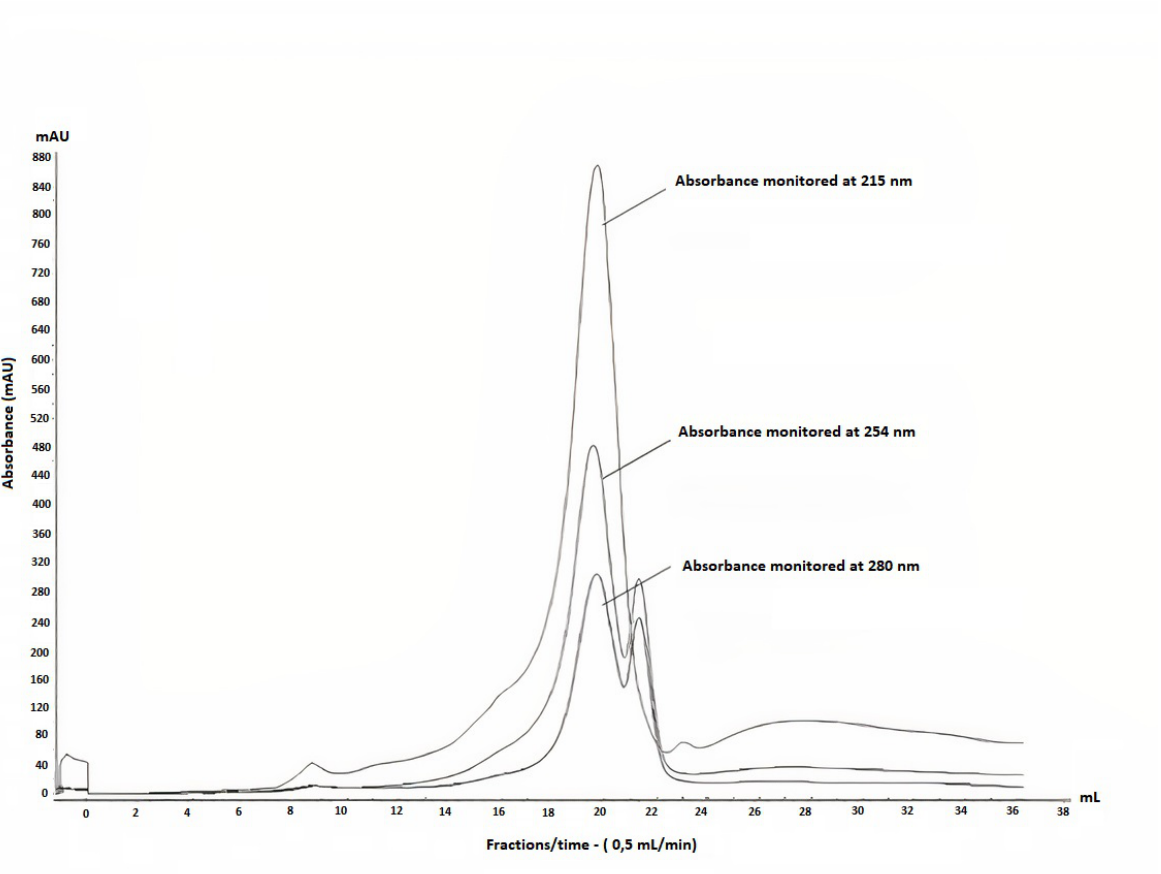
Figure 2. Chromatogram of fibrinolytic protease produced by Streptomyces parvulus DPUA 1573 and extracted by aqueous two-phase system.